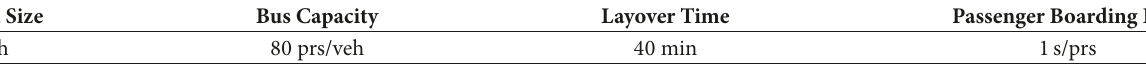
Table 6: Data Inputs for Case